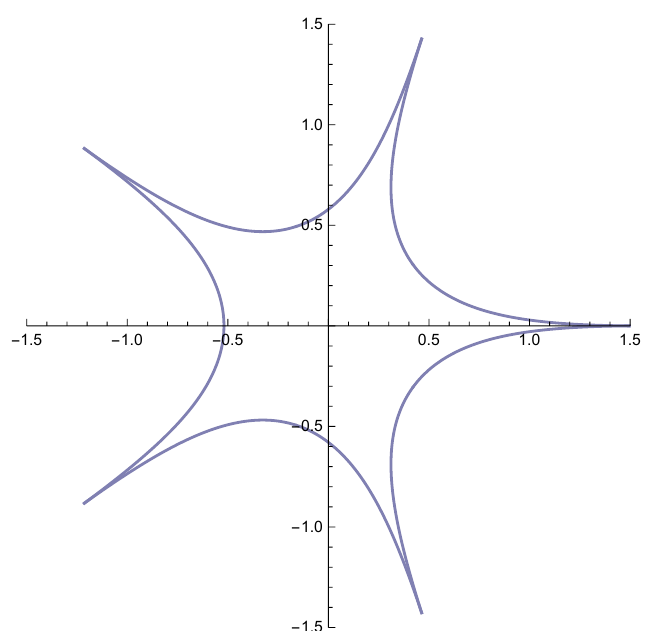
Figure 1. Closed string pro(cid:12)le with n = 5 spikes. Here we have (cid:12)xed the parameters (cid:26) 0 = 0 : 670835715 and (cid:26) 1 = 1 : 5.